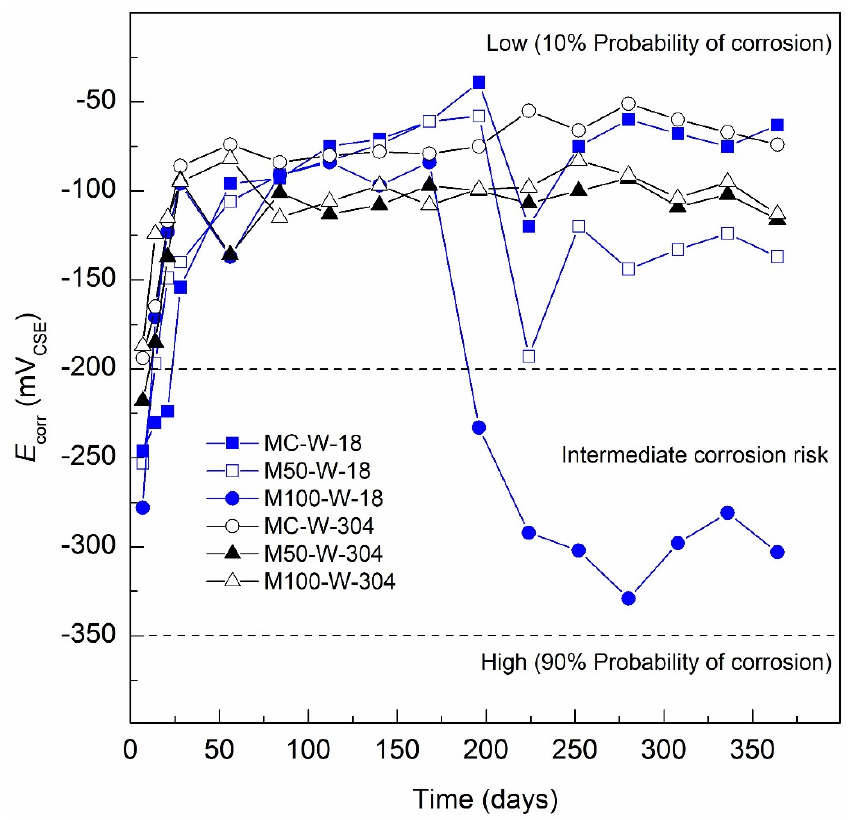
Figure 4. E corr specimens exposed DI-water (control